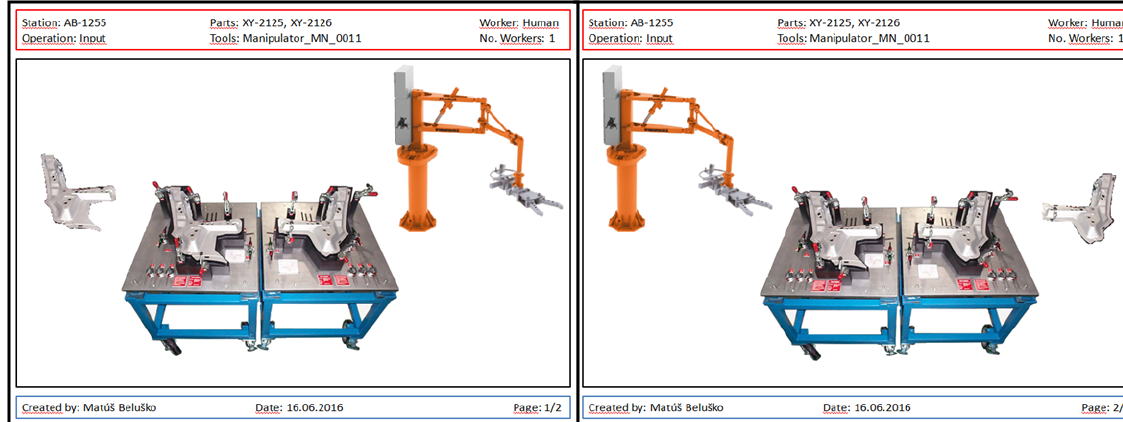
Figure 12: Instruction without overwhelmed pictures.